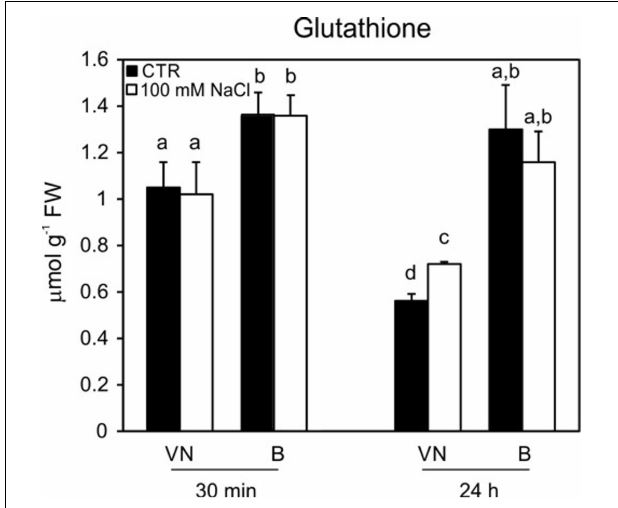
FIGURE 8 | Glutathione content in treated (100 mM NaCl) and untreated cells. Changes in cellular levels of glutathione (reduced plus oxidized forms; GSH + GSSG) pools induced by 100 mM NaCl and determined at 30 min and 24 h after treatment. Values represent the mean ± SE of three independent experiments. Different letters indicate significantly different glutathione levels according to one-way ANOVA ( p < 0.05).